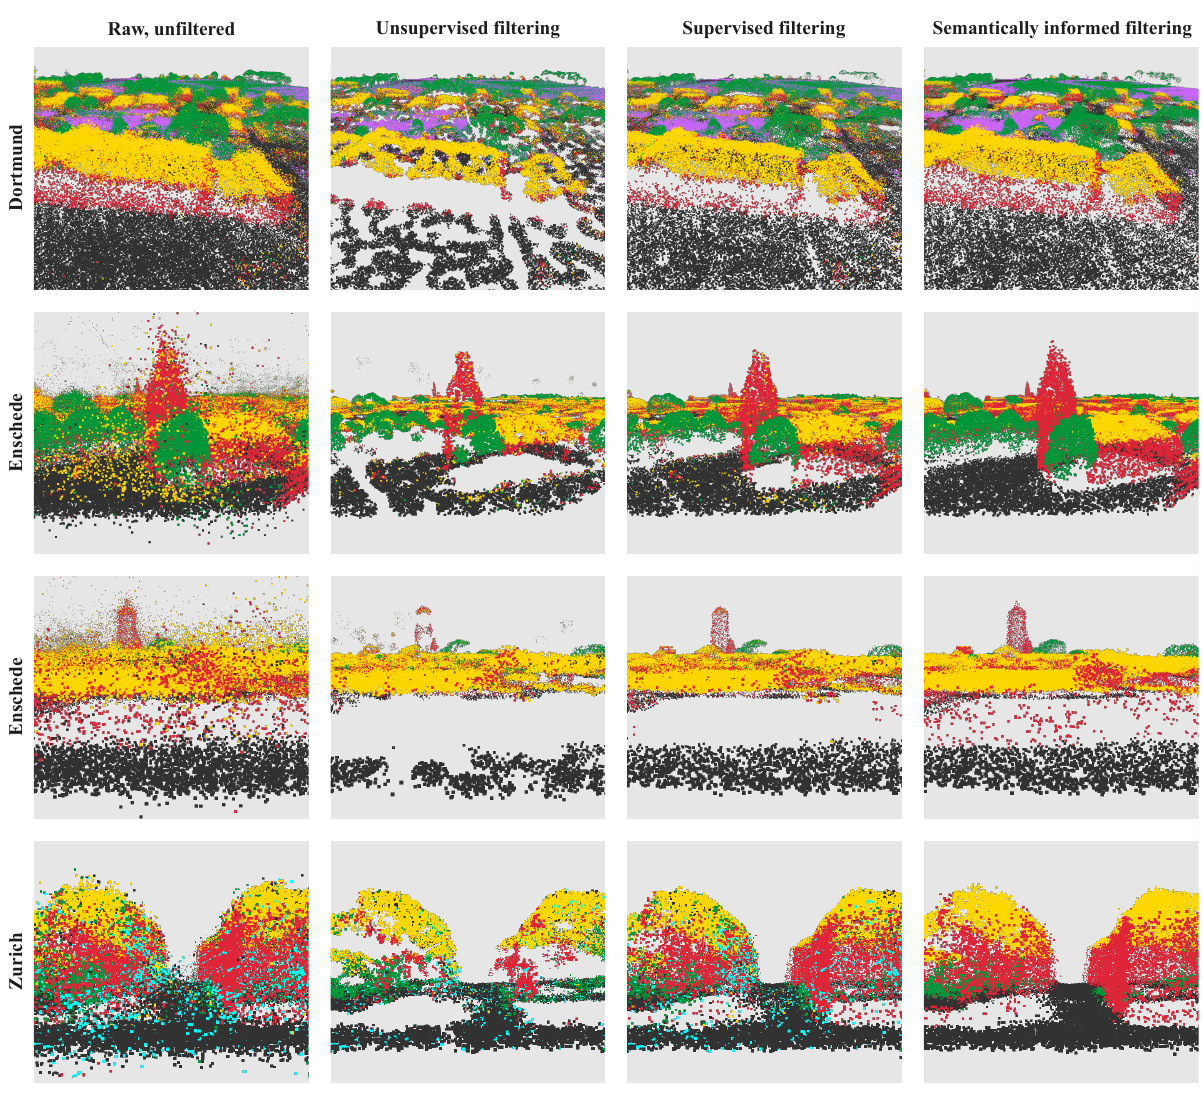
Figure 3: Qualitative filtering results. Left: Raw, unfiltered point cloud. Middle left: Filtered point cloud using unsupervised learning (Sotoodeh, 2006). Middle right: Filtered point cloud using supervised learning. Right: Filtered point cloud using semantically informed learning. The colors indicate the semantic classes building, roof, ground, vegetation, fields, and water.